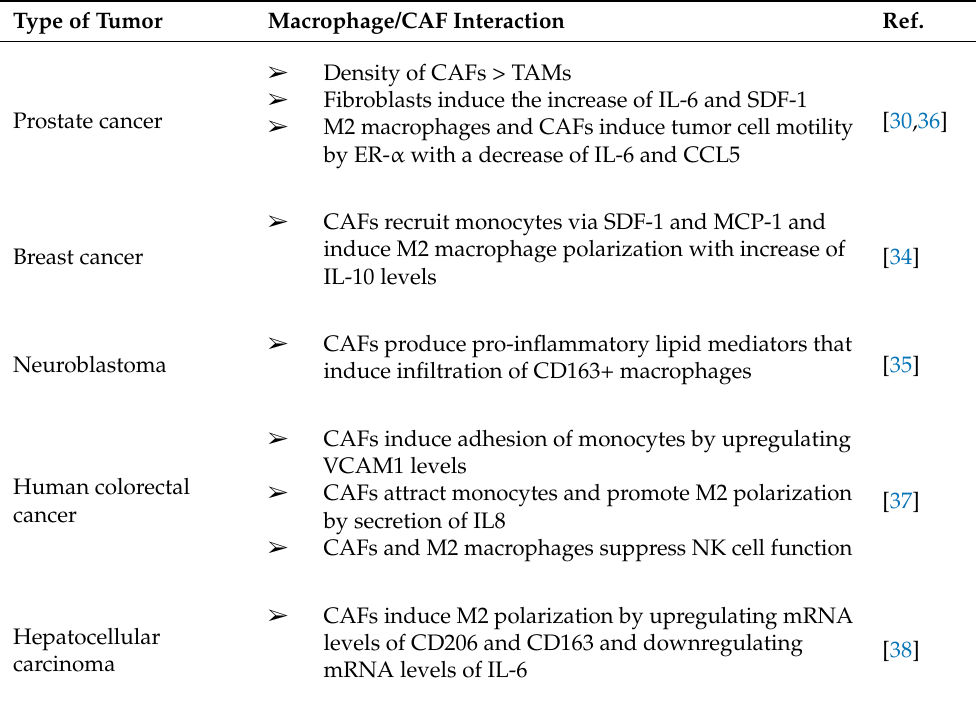
Table 1. Macrophage and CAF interaction in different tumors. Type of Tumor Macrophage/CAF Interaction